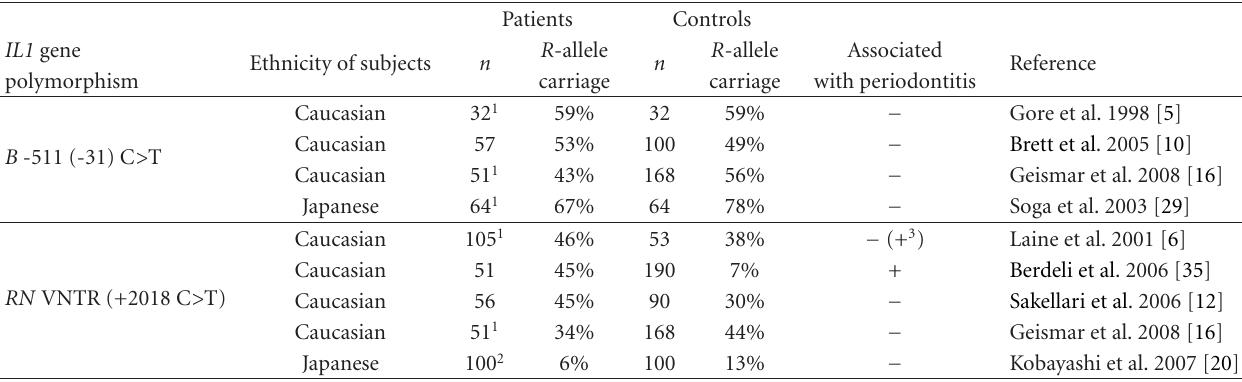
Table 3: IL1B -511 (-31) and IL1RN VNTR (+2018) gene polymorphisms and carriage rate of the Rare ( R )-allele in case-control studies and association with susceptibility to chronic periodontitis.